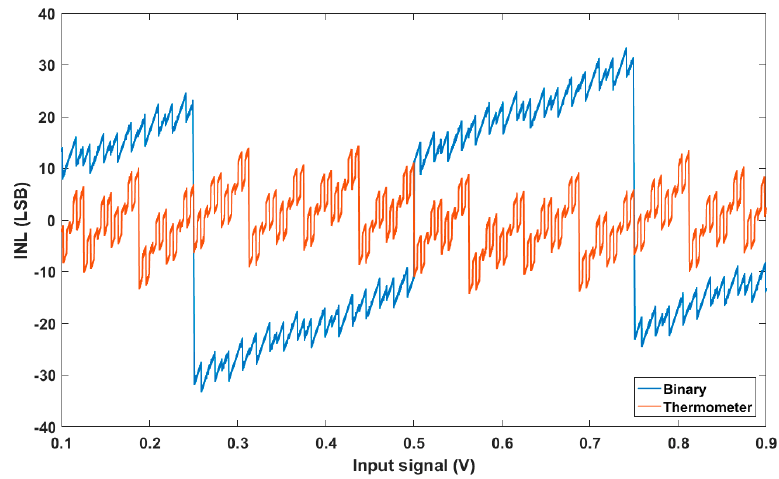
Figure 10. ADC INL for classical and thermometer-coded C-DAC.